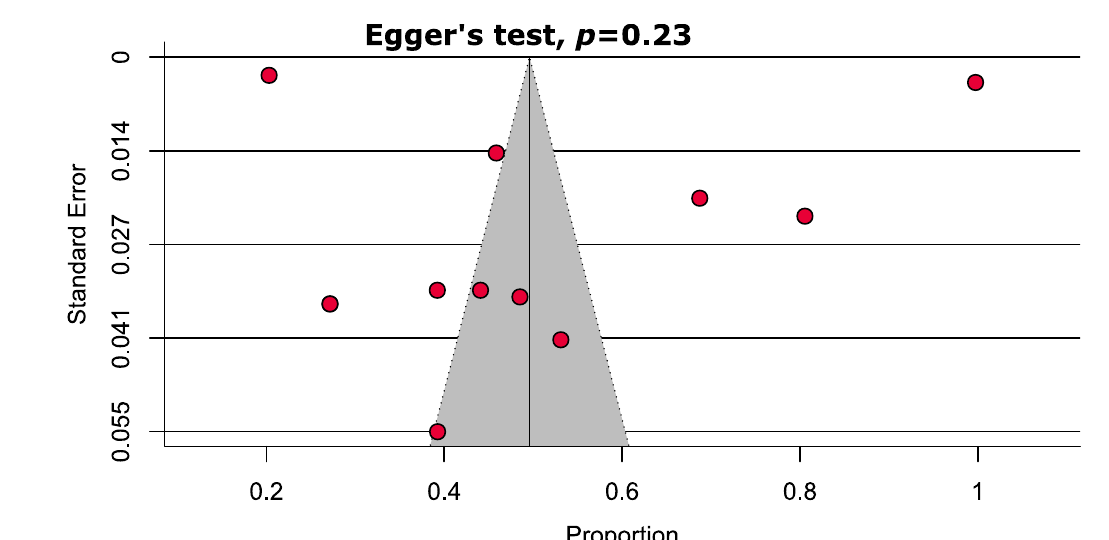
Figure 3. Funnel plot representing the prevalence of polypharmacy among elderly individuals in Malaysia showing no significant publication bias.